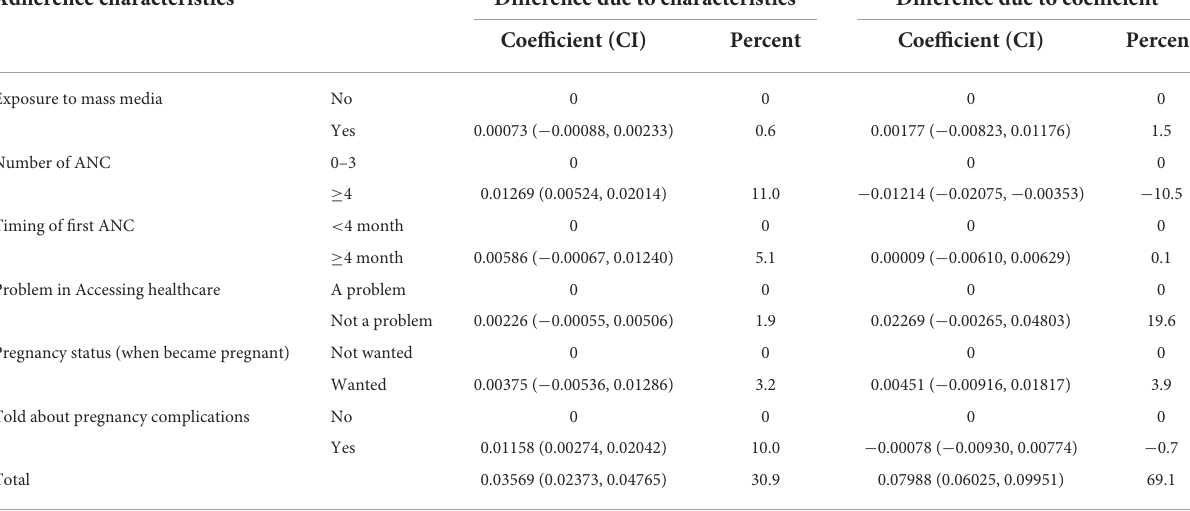
TABLE 6 Decomposition analysis of change in the adherence level to iron tablets or syrup use during pregnancy based on health service–related factors in Ethiopia (EDHS 2005–2016). Adherence